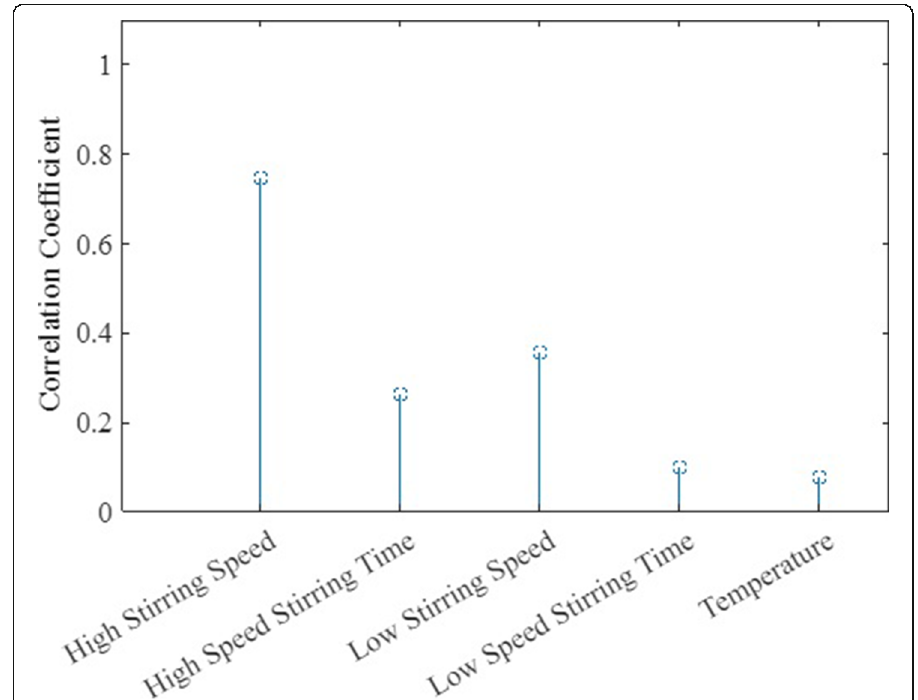
Fig. 5 Correlation coefficients between hydraulic conditions and